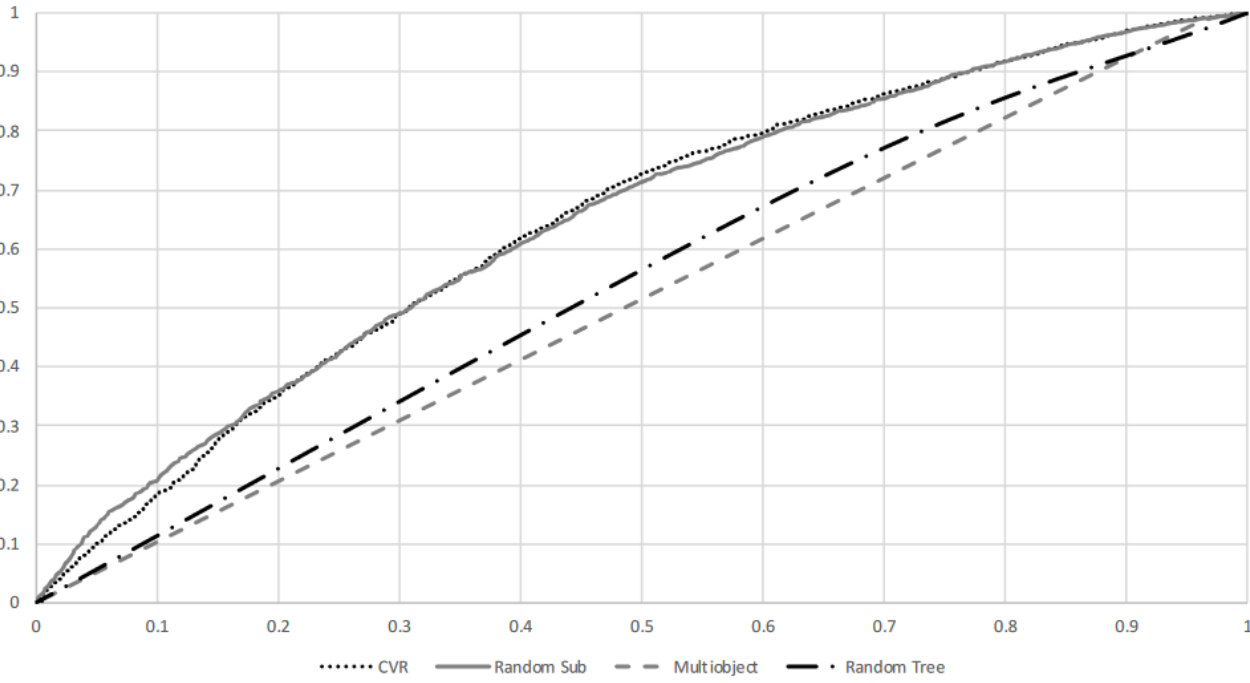
Figure 2. ROC curves for CVR, random subspace, random tree, and multiobject algorithms.